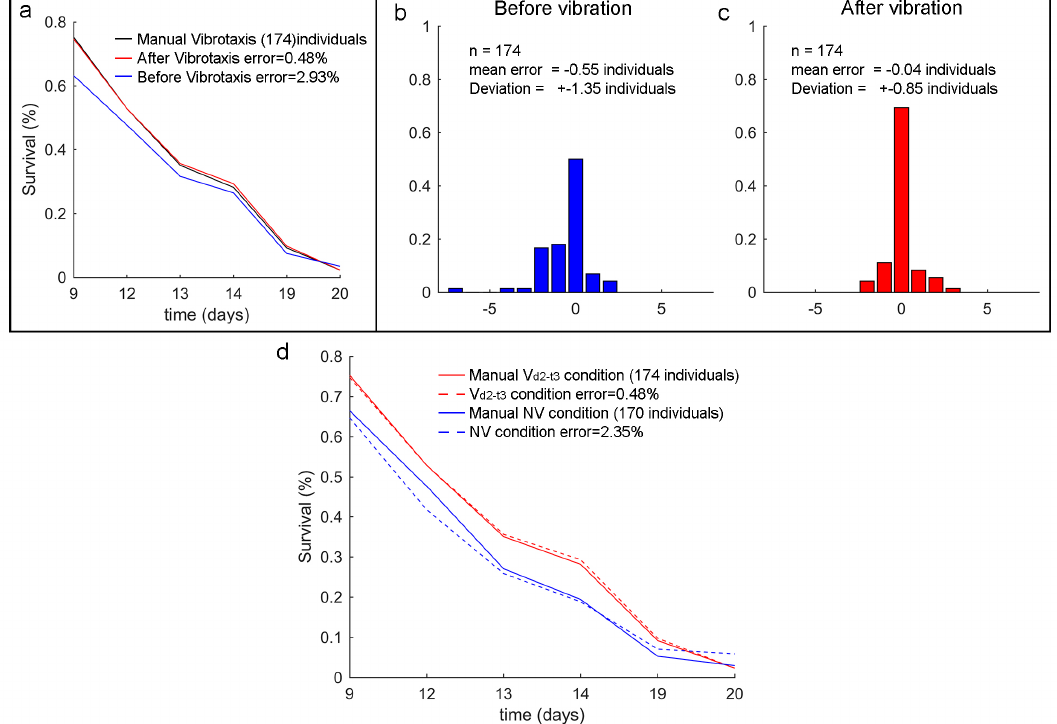
condition before 2 − t 3 2 − t 3